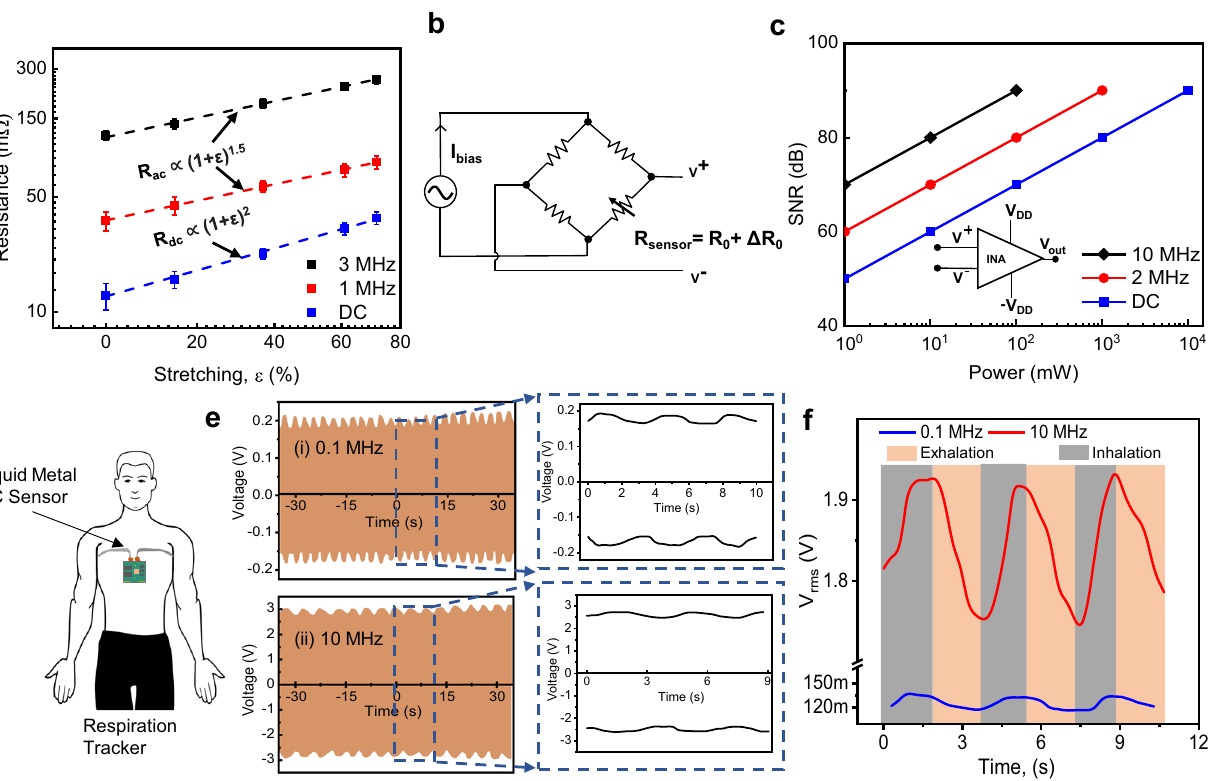
Fig. 4 Modeling of experimental AC resistance and demonstration of a low-power respiratory tracker. a Experimentally measured resistance during stretching and the predicted resistances from a mathematical model as a function of stretching at different frequencies (DC, 1 MHz, and 3 MHz) for a liquid metal wire with 1.5mm diameter. Error bars denote ± 1 s.d. b A Wheatstone bridge circuit incorporating the liquid metal sensor as R sensor . c Simulated signal-to-noise ratio (SNR) as a function of power consumption from the bias current of the Wheatstone bridge at different excitation frequencies (DC, 2 MHz, and 10 MHz). An instrumentation ampli fi er, shown in the inset, is proposed to collect differential voltage measurements of the liquid metal sensor. d Liquid metal AC sensor-based system is placed on the human chest area to collect and process respiratory data. e AC signal as a function of time for (i) low frequency (0.1 MHz) and for (ii) high-frequency (10 MHz) input signal for breathing phases (exhalation and inhalation). f V rms vs. time for corresponding breathing phases at low frequency (0.1 MHz) and high frequency (10